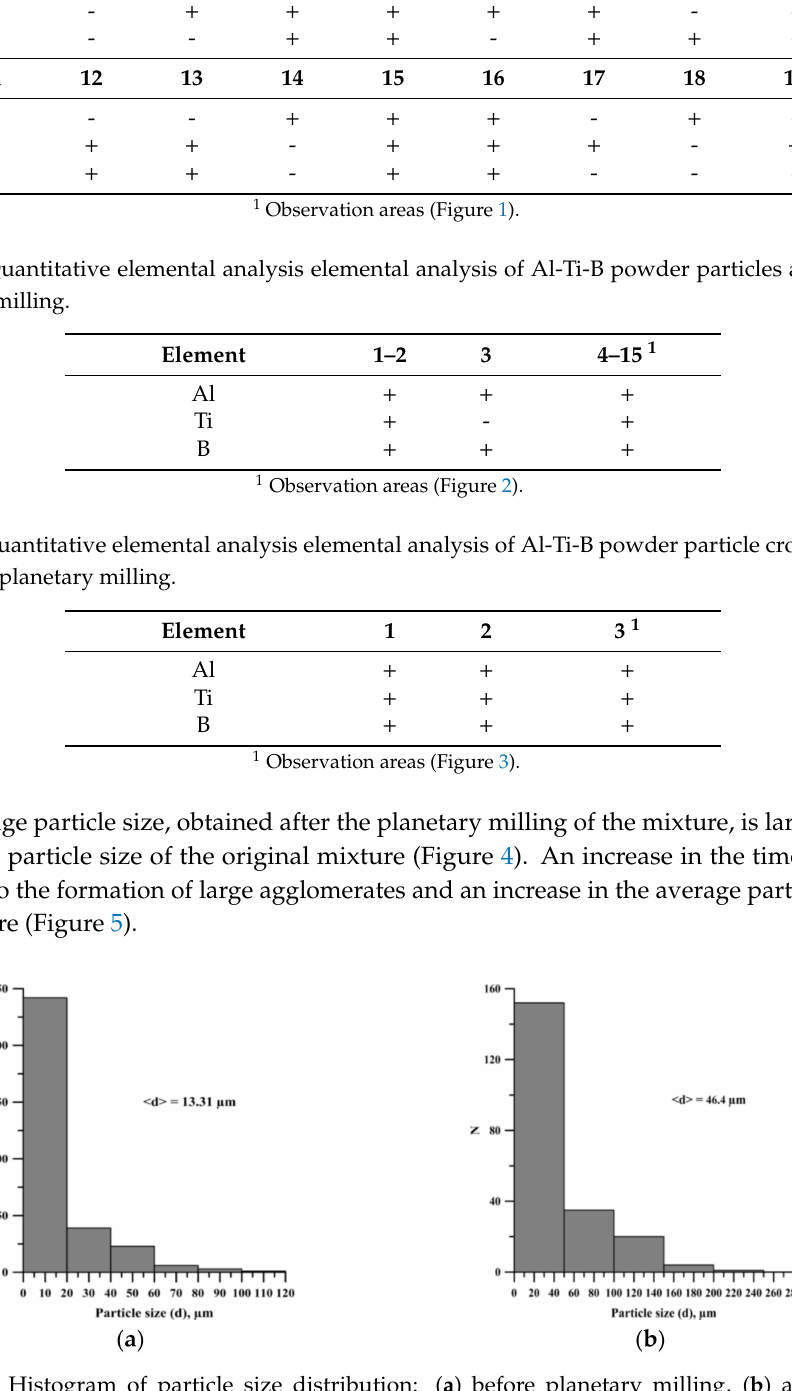
Figure 4. Histogram of particle size distribution: ( a ) before planetary milling, ( b ) after 900 s planetary